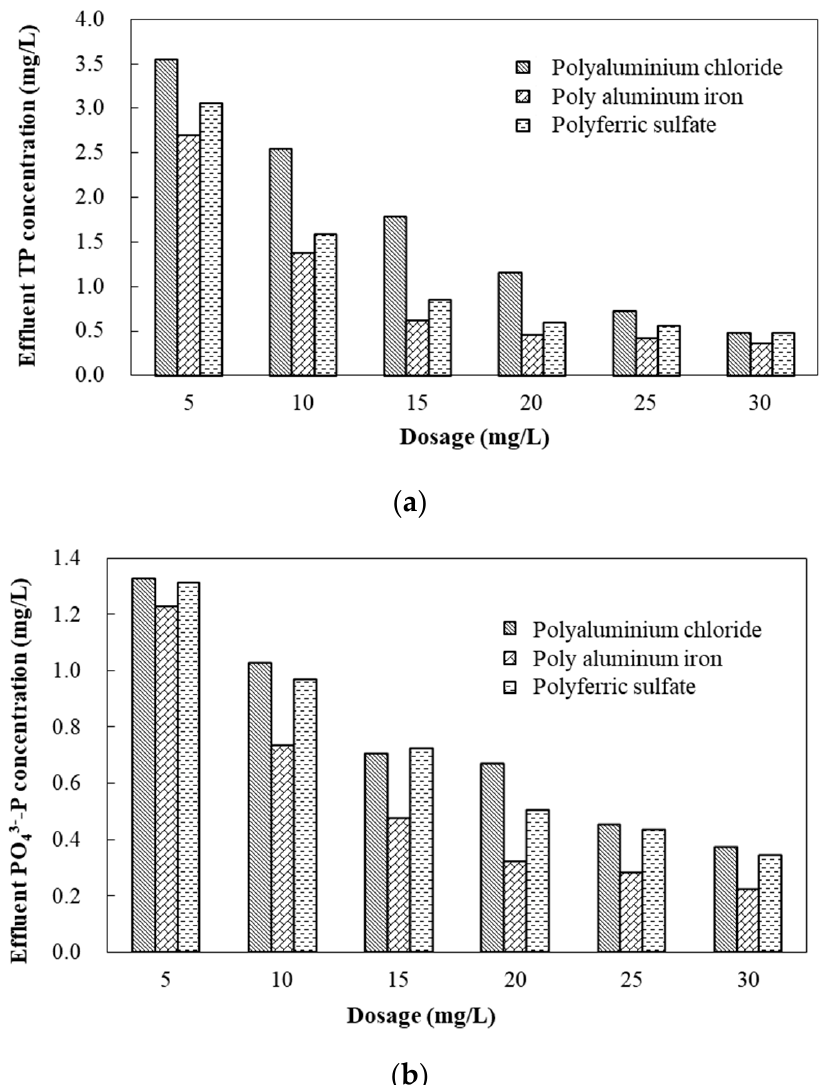
Figure 16. ( a ) The effect of phosphorus removal agents on TP removal; ( b ) The effect of phosphorus removal agents on PO 43 − –P removal.